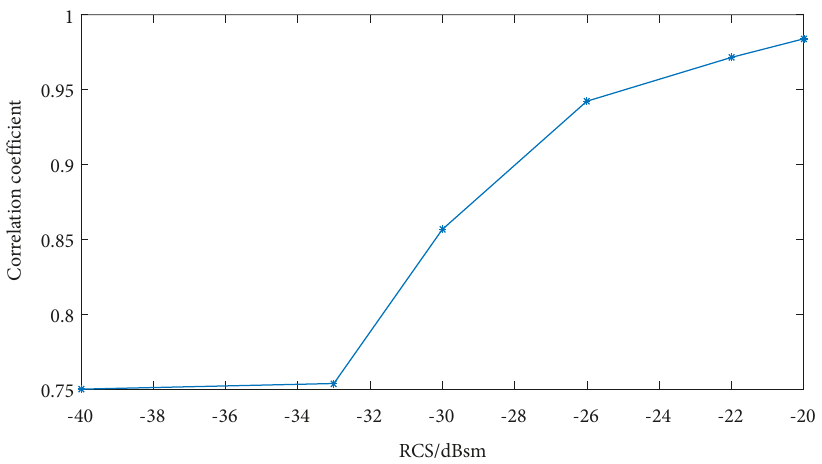
Figure 10: The correlation coefficient between the KLD information distance matrix of different RCS values and the reference matrix.